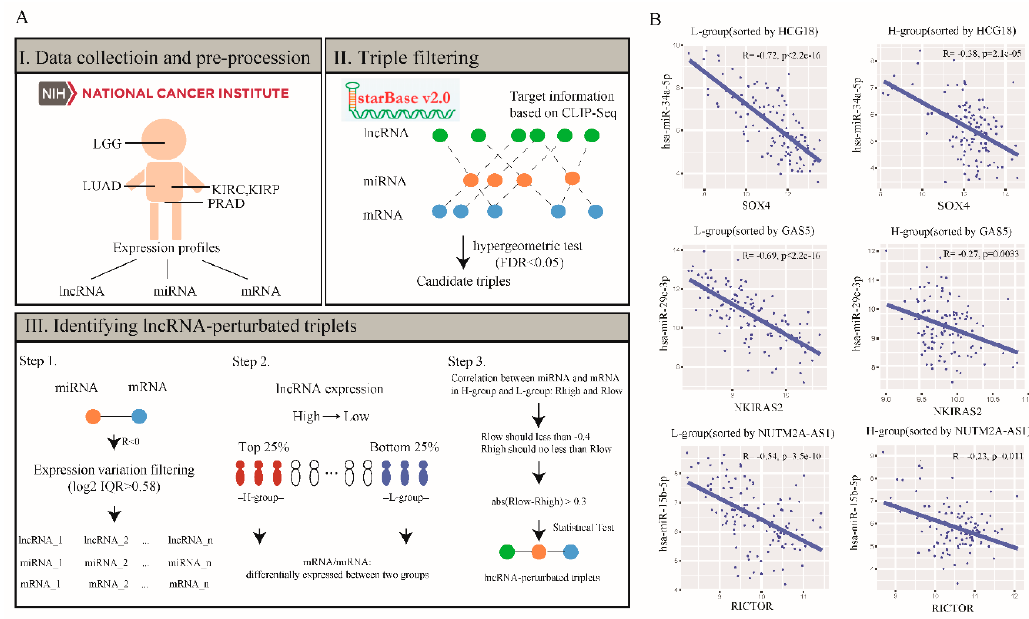
Figure 1. The overview of identification of lncRNA-perturbated triplets in cancer. ( A ) Workflow. The process mainly involved the following three steps: (I) Data collection and